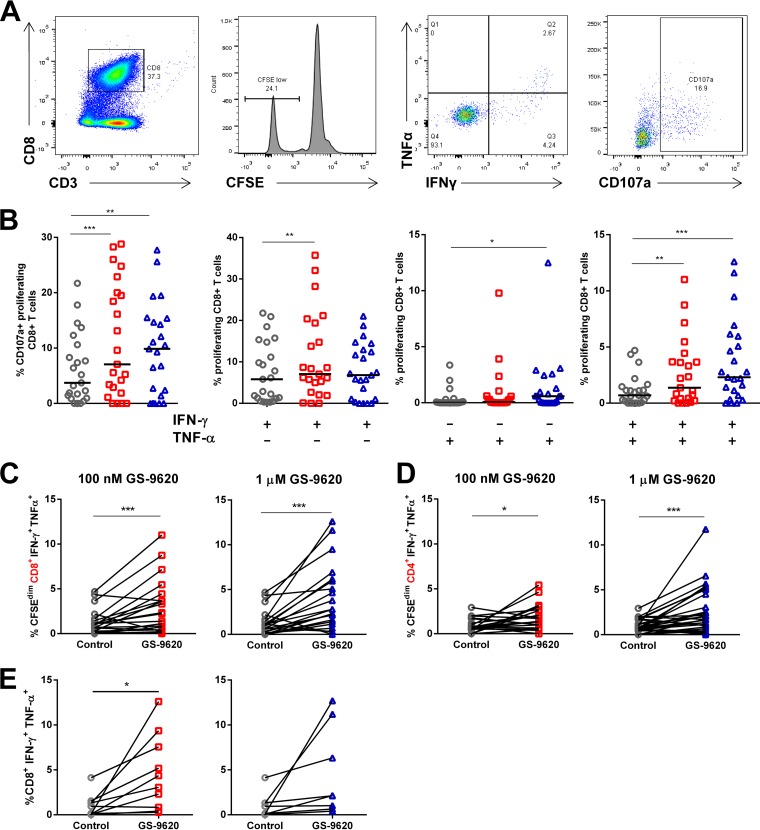
GS-9620 enhances polyfunctionality of HIV-specific CD8+ and CD4+ T cells. CFSE-labeled PBMCs were isolated from ART-suppressed HIV-infected individuals (n = 23) and stimulated with a pool of HIV peptides (derived from Gag, Nef, Env, and Pol) with or without GS-9620 for 8 days. The cells were then treated a second time with the same HIV peptides, stained for activation, and analyzed by flow cytometry. (A) Representative gating for proliferating (CFSE low) CD8+ T cells positive for CD107a or IFN-γ and TNF-α. (B) Scatter plots showing the percentages of proliferating (CFSE dim) CD8+ and CD4+ T cells expressing CD107a, IFN-γ, TNF-α, or IFN-γ and TNF-α. The cells were treated with vehicle control (circles), 100 nM GS-9620 (squares), or 1 μM GS-9620 (triangles). Each symbol represents data from a single individual, with the horizontal bars indicating medians. (C and D) Intracellular cytokine staining was used to assess production of IFN-γ and TNF-α in proliferating CD8+ (C) and CD4+ (D) T cells compared to vehicle control-treated samples. The lines connect values from the same individual. (E) CFSE-labeled PBMCs were isolated from healthy donors and stimulated with a pool of common antigenic (CEFT) peptides with or without GS-9620 for 8 days. The cells were then treated a second time with the same CEFT peptides, stained for activation, and analyzed by flow cytometry. The cells were treated with vehicle control (circles), 100 nM GS-9620 (squares; n = 10), or 1 μM GS-9620 (triangles; n = 8). The P values were determined by paired Student's t tests. *, P < 0.05; **, P < 0.01; ***, P < 0.001.